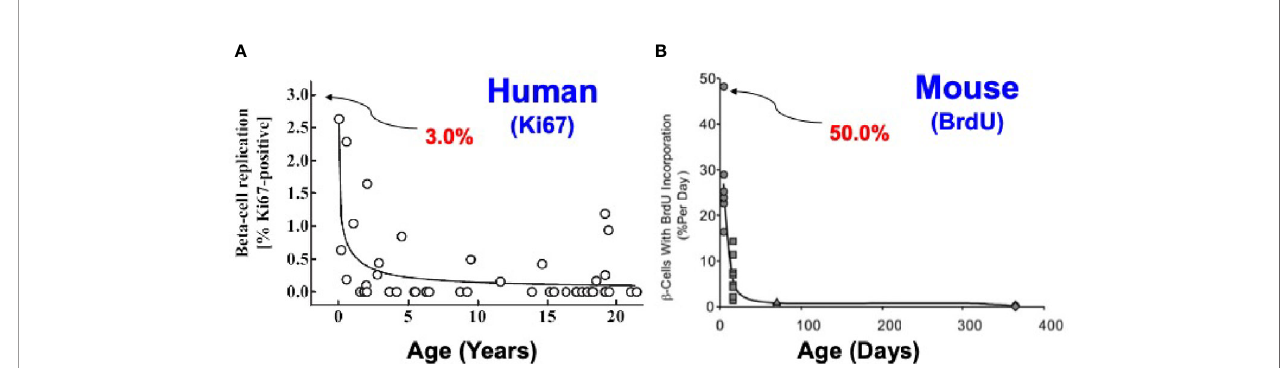
FIGURE 2 | Comparison of Beta Cell Proliferation Rates as a Function of Age in Humans and Mice. The key point is that beta cells replicate at high rates in juvenile humans and mice, and decline with age. With age (early adult hood in humans and ~12 months in mice), beta cell replication ceases and is dif fi cult or impossible to re-activate in both species. Note that at birth, beta cell proliferation is much higher in rodents than in humans. Note also that most rodent studies employ animals that are 2-3 months of age, whereas most human studies employ islets from organ donors who are 40-55 y.o. Similar studies are available in (27, 30, 31). (A) Is reprinted with permission from (26). (B) Is reprinted with permission from